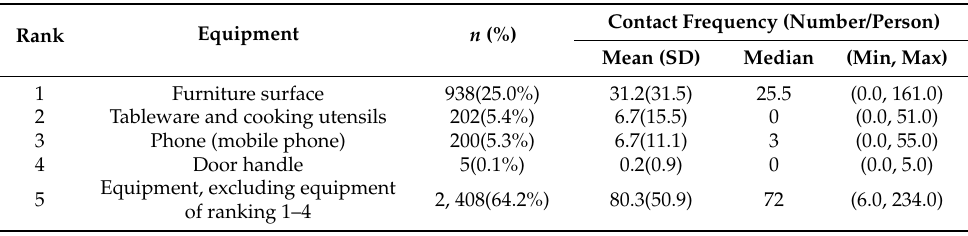
Table 2. Contact frequency for equipment items observed to have the maximum hand-to-environment contacts (2-hours observation time, N =